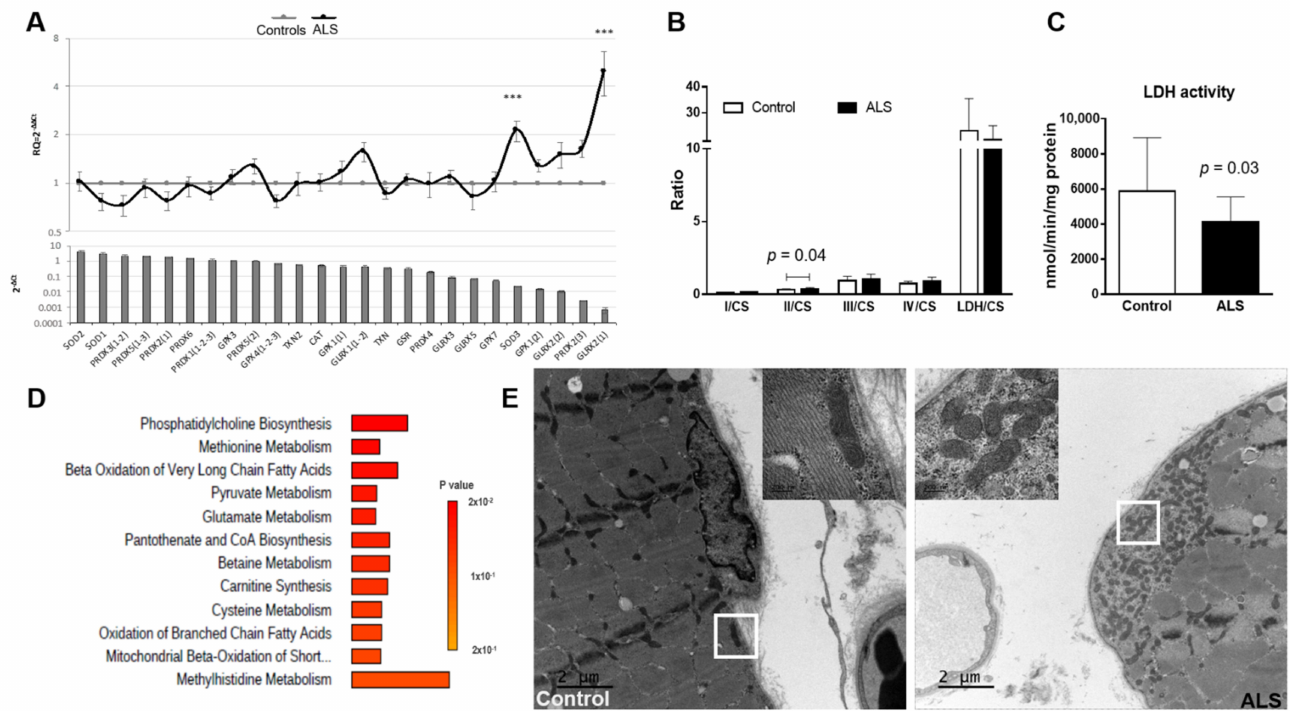
Figure 3. Alterations in muscle mitochondria. ( A ) Antioxidant genetic profile of ALS samples compared to controls. Expression levels of 25 transcripts of key antioxidant genes in the muscle of ALS patients (upper panel). Transcripts are ranked in decreasing order of expression in controls (bottom panel). Results are expressed as relative quantification (RQ) compared with control data (mean ± SEM). The horizontal gray line (y = 1) represents the healthy control profile ( n = 20), and the black line represents patients’ data. Significant difference with the healthy controls ( ∆ Ct values), *** p < 0.001. ( B , C ) Mitochondrial enzymatic activity from muscle of ALS patients and control subjects. ( B ) Ratios of analyzed complexes revealed alterations in the ratio Complex II/Cytrate synthase (II/CS; p = 0.04) and ( C ) in LDH activity ( p = 0.03). No differences were found in the activity of the other complexes or ratios. Control: n = 20; ALS: n = 17. Results are shown as mean ± standard deviation. Data was analyzed using the Mann-Whitney statistical test. ( D ) Enrichment analysis of metabolites significantly correlated with LDH activity in muscle of ALS patients. Analysis performed with MetaboAnalyst tool. ( E ) Ultrastructural alterations in muscle mitochondria from ALS patients compared to control subjects. Representative transmission electron microscopy (TEM) images revealed the presence of mitochondria aggregates in the subsarcolemnic space in the muscle of ALS patient but not in the control subject. Scale bar: 2 µ m. The insert corresponds to the zone indicated by the white box. Scale bar: 200